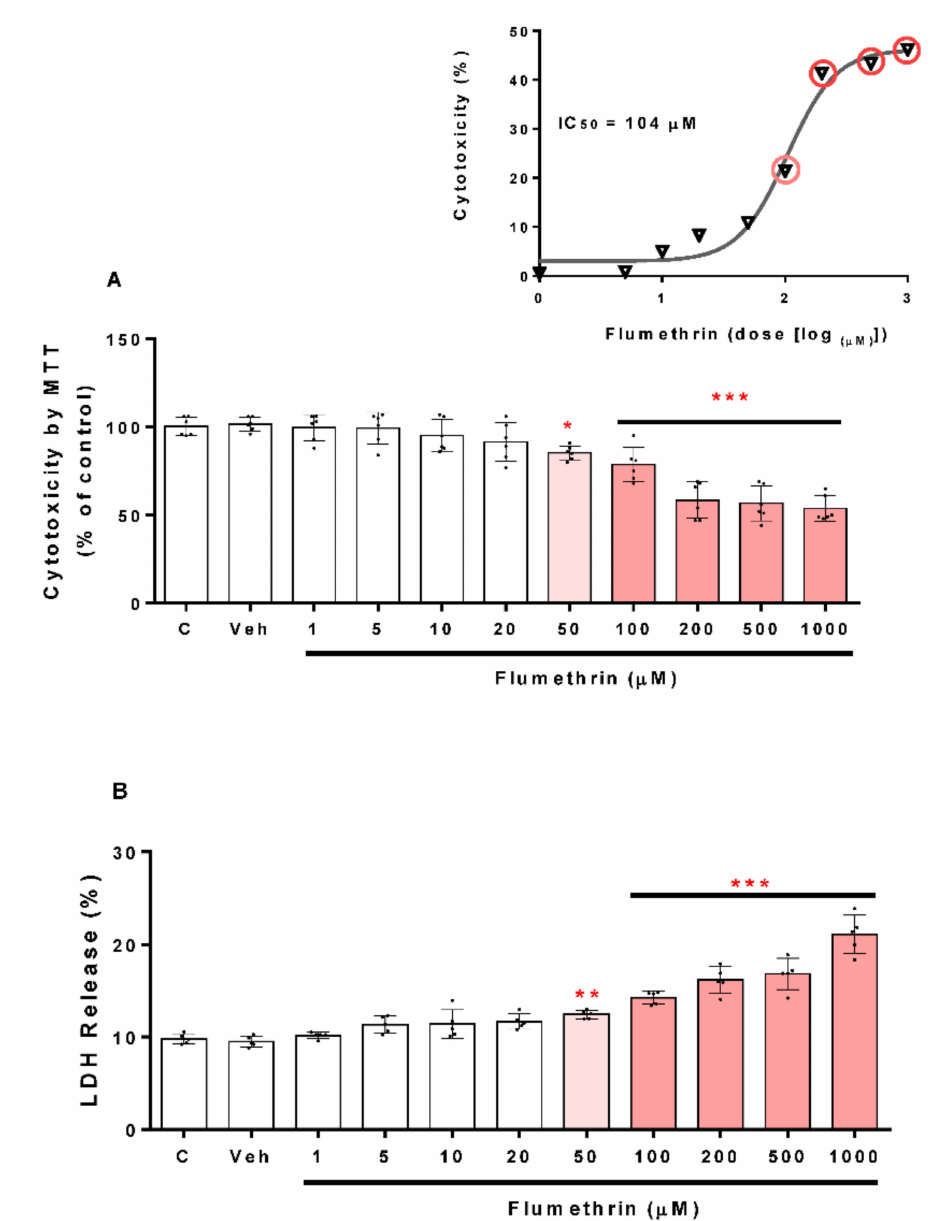
Figure 1. The cytotoxicity induced by flumethrin (1–1000 µ M) on the viability of the SH-SY5Y cell line after a 24 h incubation period. Cell viability was determined by MTT reduction, and the MTT reduction (%) dose-response curve was used to obtain the IC 50 value ( A ), or as LDH release ( B ). Data was normalized as % control (c). DMEM-treated cells with 1% FBS were the positive control (c), and cells with 0.1% DMSO were the negative control (Veh). Results are presented as the mean ± SD of six replicates. * p < 0.05, ** p < 0.01, *** p < 0.001 compared to